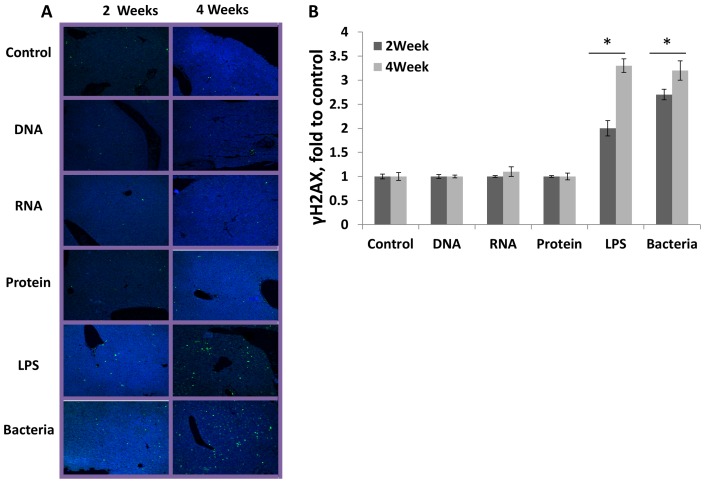
Immunohistochemical analysis of liver tissue samples stained with DAPI staining and Green Fluorescent antibody for γH2AX.A. Images taken from animals in the group exposed to tap water (control), DNA, RNA, protein, LPS and whole heat-killed bacteria. B. Bars show the average (with SD) fold difference in number of γH2AX-positive cells between treated and control groups. Asterisks show significant difference from control (p<0.05).